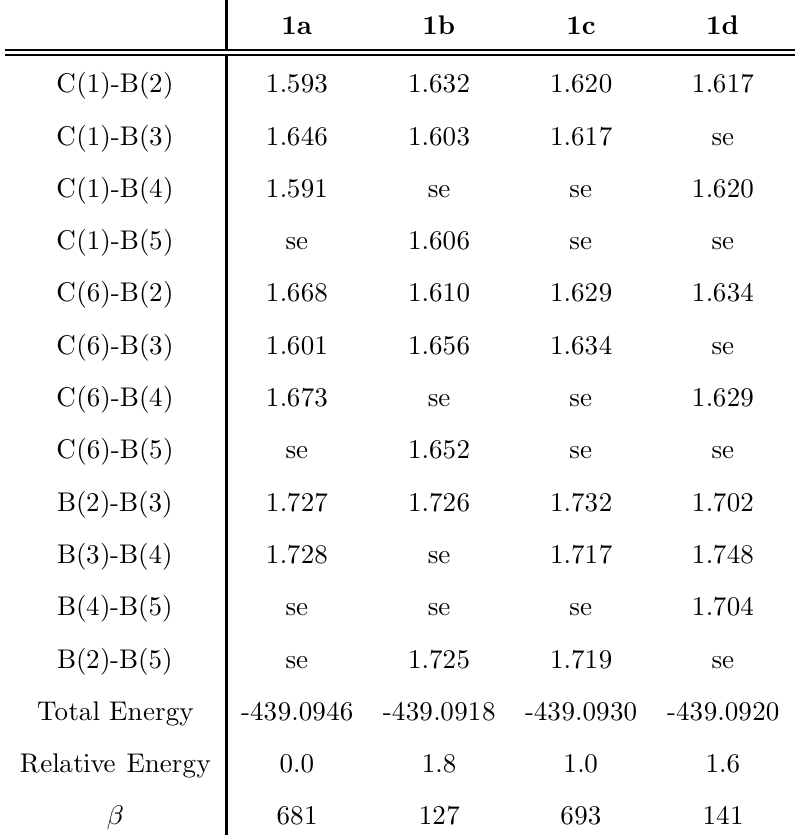
Table 1 (First half) Main bond lengths (¸A), total energies (au), relative energies (kcal/mol) and molecular hyperpolarizabilities (au) of conformers 1 a-d and 2 a-d. (For unsubstituted 1-6-C 2 B 4 H 6 , bond lengths are 1.625 ¸A for B-C and 1.713 ¸A for B-B bonds). Relative energies are calculated assuming energy for 1a for CCCARB and for 2a for BBCARB to be